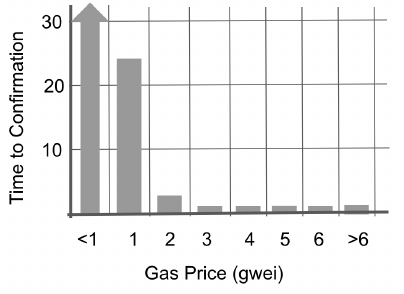
Figure 4: Transaction Confirmation Time versus Gas